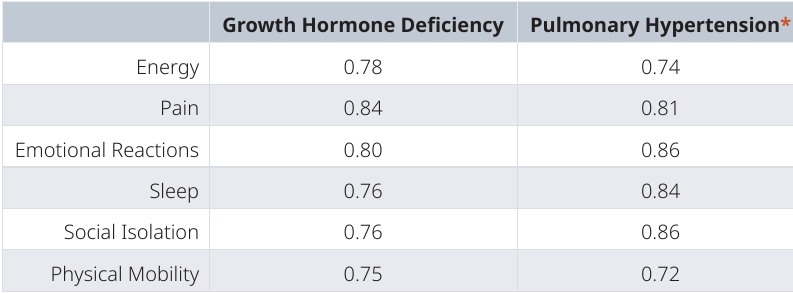
Table 3. Cronbach’s alpha coefficients for NHP sections in GHD (n=122) and PH (n=102)